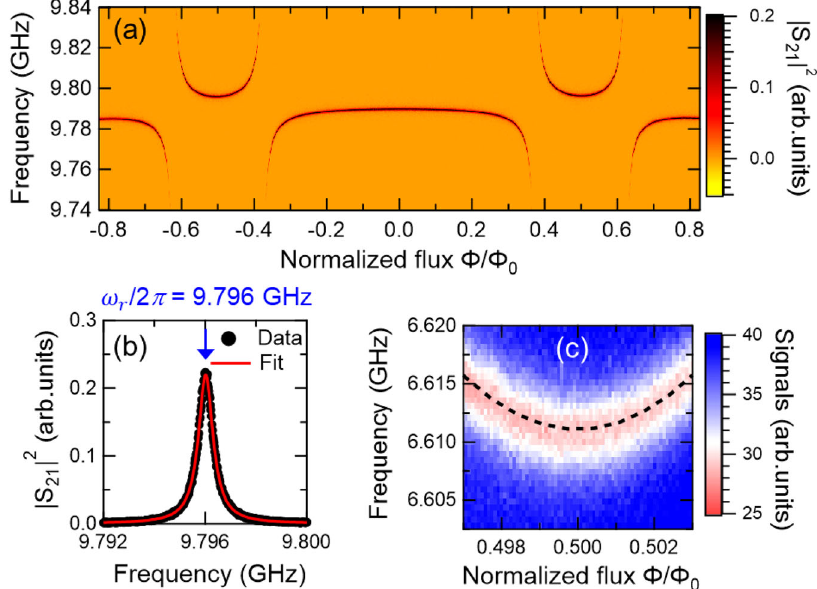
Fig. 2 Spectroscopy of resonator and qubit. a Spectrum of resonator microwave transmission ( S 21 ) with varying probe frequency and normalized fl ux ¼ 0 : 5 with a Lorentzian fi t (solid line). c Qubit spectra obtained using dispersive ). b The line pro fi le of the resonator ’ s spectrum at fl ux bias Φ = Φ ( Φ = Φ 0 0 readout. The dashed line is a simulation curve for the qubit transition from the ground state to the excited state ( ω 01 = 2 π ). The qubit transition frequency has a minimum value of 6.61 GHz at the fl ux-insensitive point. as the area ratio of the small JJ relative to the two larger JJs = h ¼ 140 GHz (where h is the α ¼ 0 : 358, Josephson energy E J Plank constant, and the corresponding critical current density of the larger junctions in the qubit is 38.6 A cm − 2 ), and charging energy = h ¼ ð e 2 = 2 C Þ = h ¼ 0 : 244 GHz. Here, the total qubit capaci- E Σ C = 52.8 tance ( C Σ ) is 79.6 fF, which includes a shunt capacitance C S ¼ 26 : 8 fF fF and the total junction capacitance of the fl ux qubit C J (the detailed parameters are also found in the Methods).